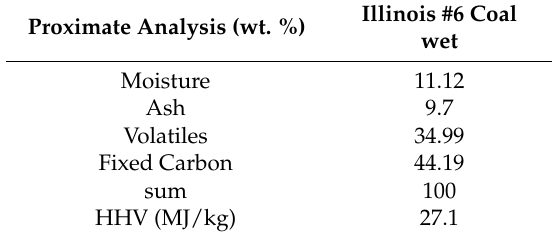
Table 2. Proximate analysis of feedstock coal.